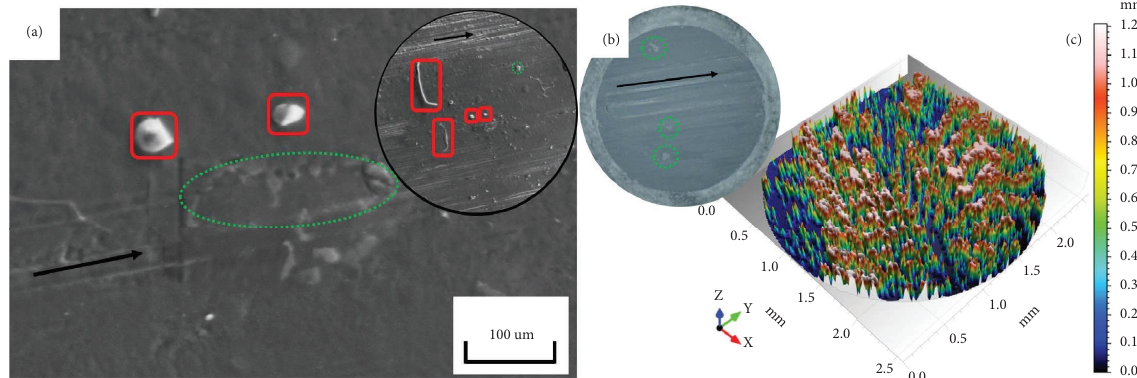
Figure 8: SEM image, optical microscopy, and 3D surface topographies of the wear track of the POM